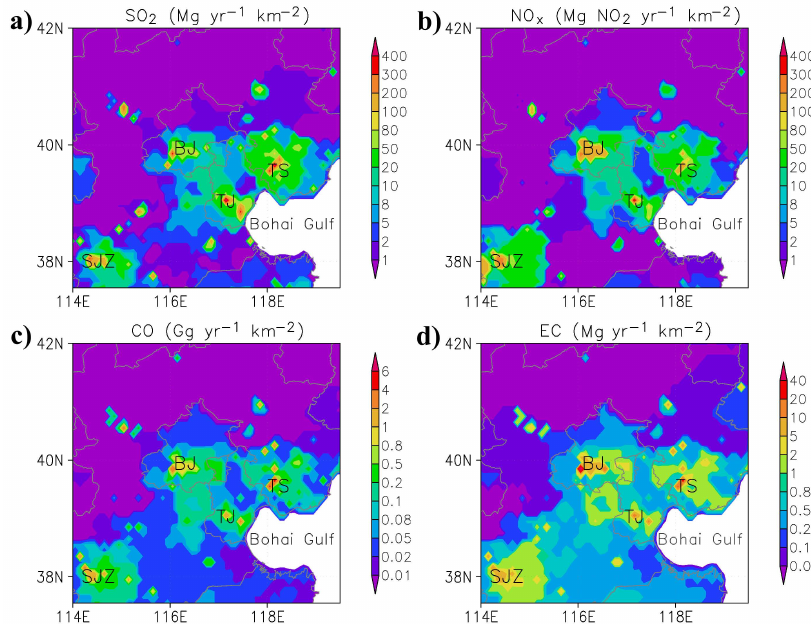
Fig. 1. Primary pollutant emissions in the central area of Huabei. Strong emissions from the Beijing (BJ), Tianjin (TJ), Tangshan (TS) and Shijiazhuang (SJZ) cities are clearly visible.